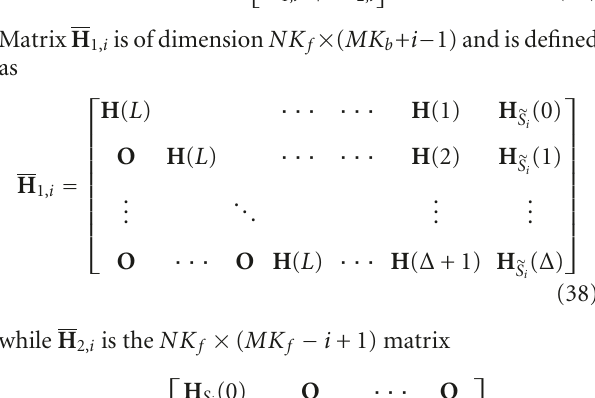
Algorithm 2: The proposed SRC algorithm.